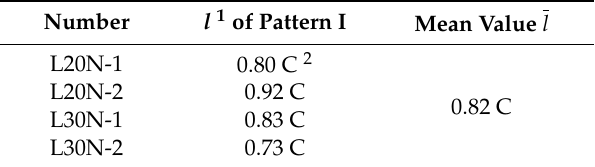
Figure 9. Cracking pattern I. Table 7. The distribution range of corrosion-induced